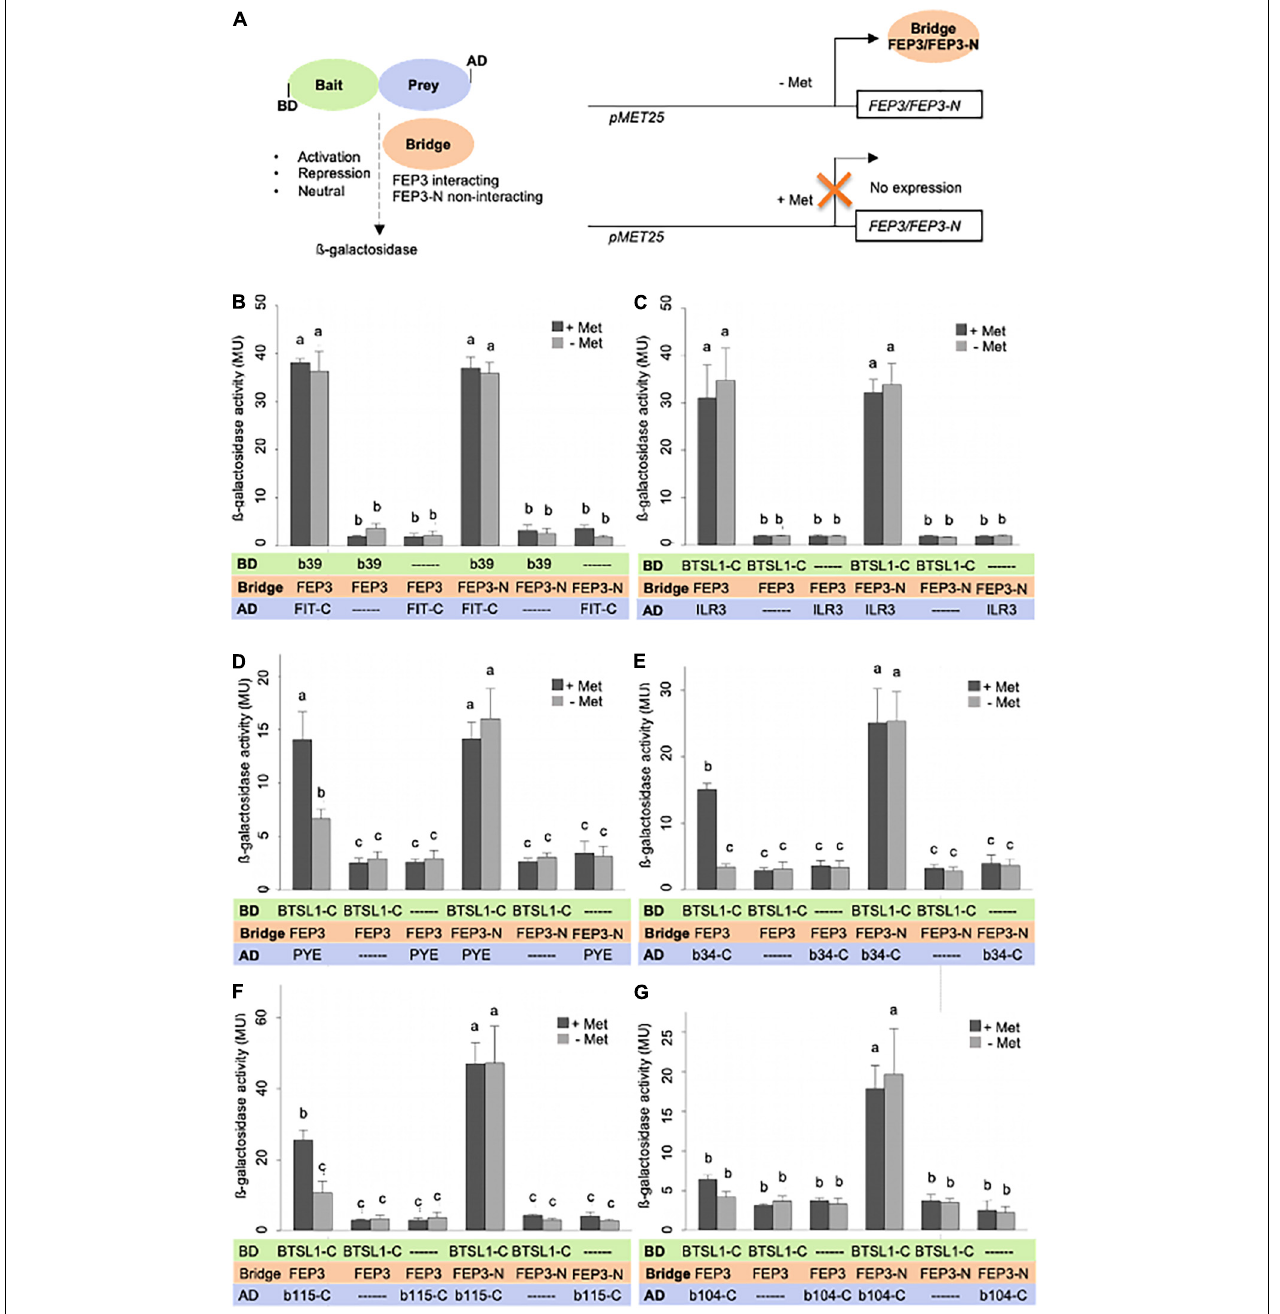
FIGURE 7 | FEP3/IMA1 effect on BTSL1-C and bHLH IVb and IVc interaction quantified by yeast three hybrid (Y3H) assay. (A) Schematic representation of Y3H principle and design. Left, the protein interaction strength between a bait protein (fused with Gal4 DNA binding domain, BD) and prey protein (fused with Gal4 activation domain, AD) is measured by ß-galactosidase activity, here BTSL1-C and a bHLH protein (part). The effect of a bridge protein on protein interaction is measured, here interacting FEP3/IMA1 and negative control non-interacting FEP-N, leading to either activation, repression or neutral effect on bait-prey protein interactions. Note that the term “bridge” is a neutral term, and depending in the result the "bridge” protein may act as positive or negative effector protein or have a neutral effect. Right, the Bridge protein is expressed under a pMET25 promoter by supplementation with or without methionine (+Met, -et). (B–G) Quantification of protein interaction strengths in absence and presence of bridge protein FEP3 or FEP3-N ( ± Met) of panel (B) FIT-C-bHLH39, (C) BTSL1-C-ILR3, (D) BTSL1-C-PYE, (E) BTSL1-C-bHLH34-C, (F) BTSL1-C-bHLH115-C, (G) BTSL1-C-bHLH104-C interactions. Yeast cells are grown in SD-LWM, for bridge protein expression and SD-LW for repression of bridge protein expression; ß- galactosidase activity is determined in Miller Units (MU). Data are represented as mean values with standard deviations. Different letters indicate statistically significant differences (one-way ANOVA and Tukey’s post-hoc test, n = 5, p < 0.05). Immunoblot analysis of FEP3/IMA1 is shown in Supplementary Figure 13